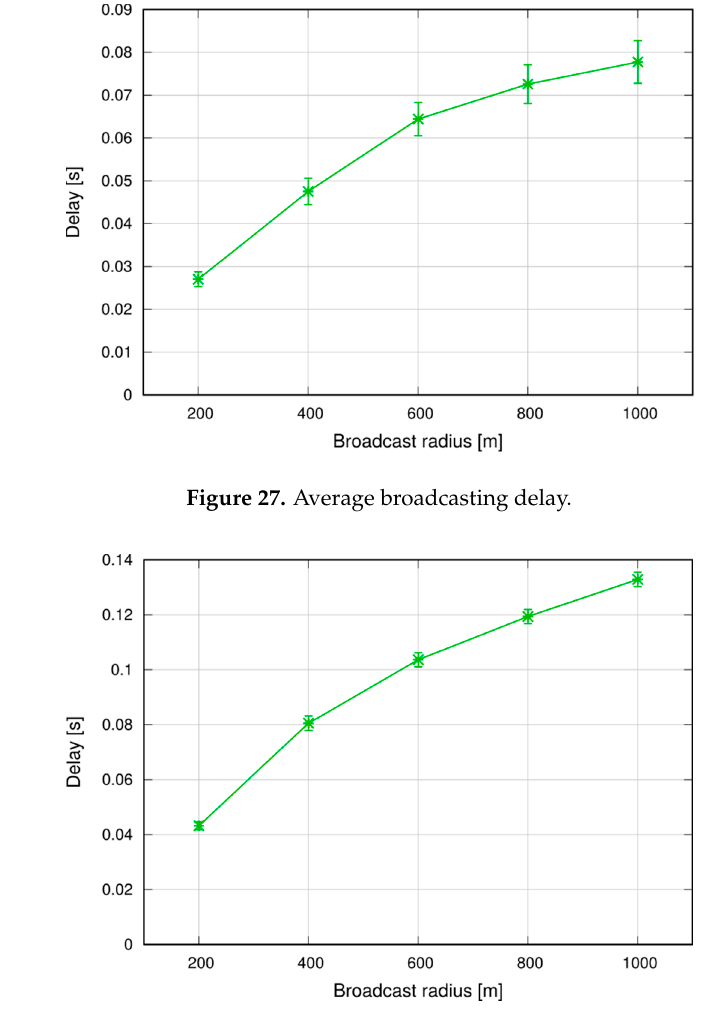
Figure 29. Example of broadcasting. The dashed circle delimits the broadcast area.